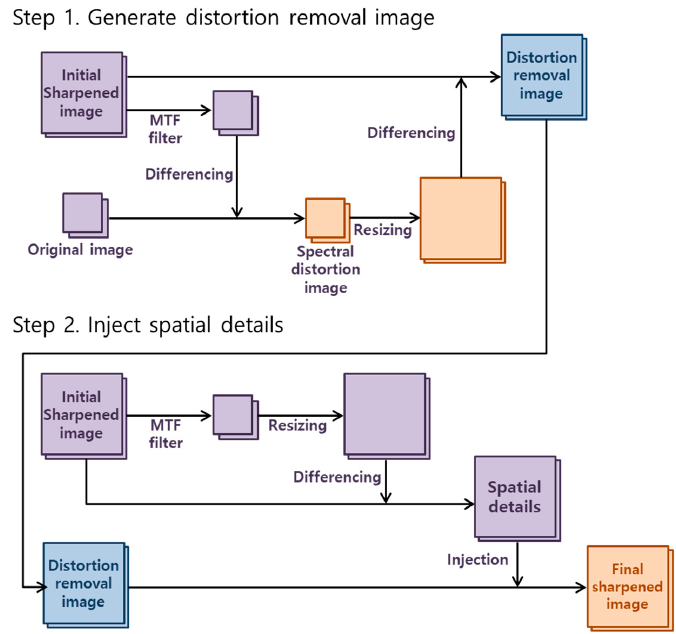
Figure 3. Workflow of the spectral distortion technique.